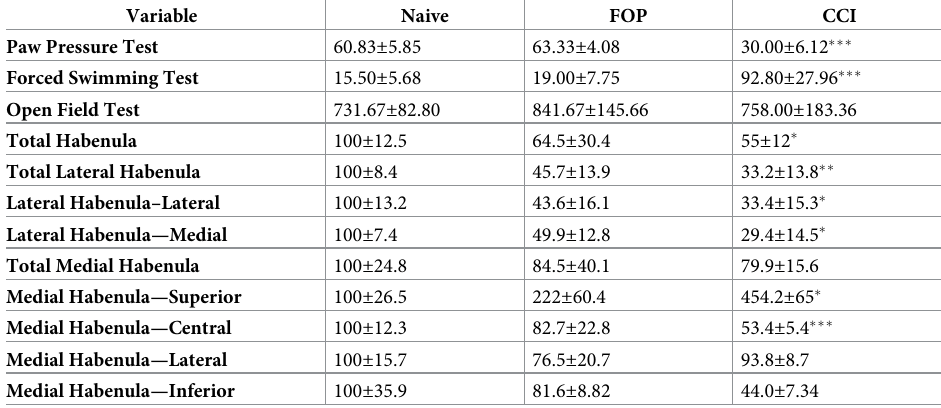
Table 1. Mean and standard deviation—behaviour and habenula c-fos